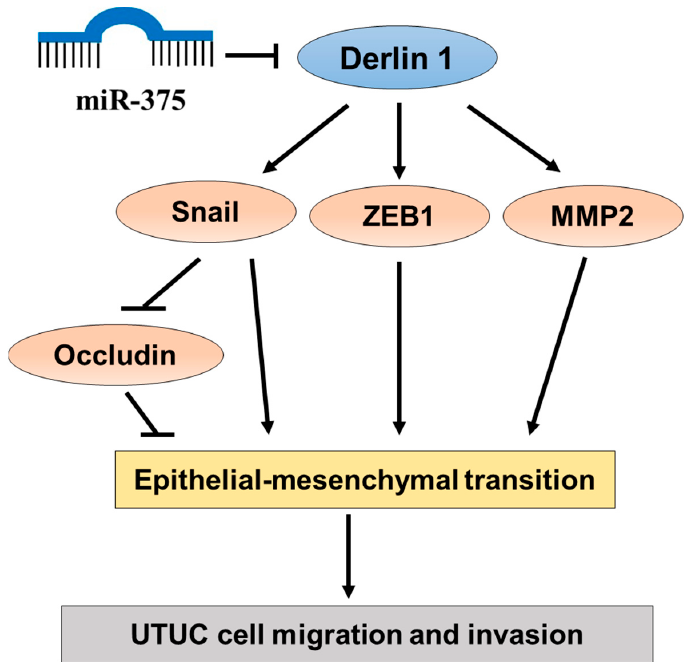
Figure 6. A schematic illustration of miR-375-3p/Derlin-1 mediated UTUC cell migration and invasion through EMT.